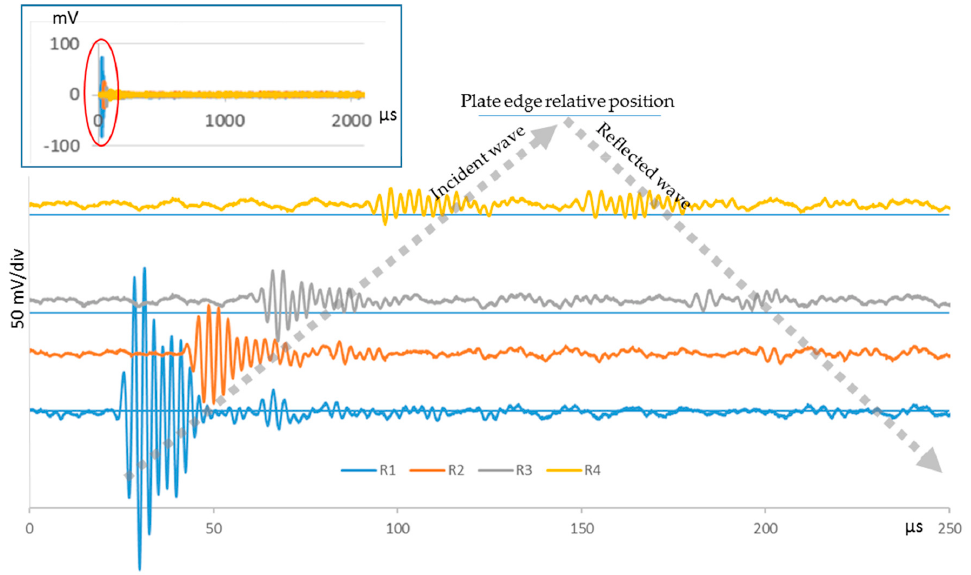
Figure 4. Signals acquired at R1–R4 during the basic UGWT. The upper part corresponds to the signal acquisition for 2 ms. The lower part corresponds to the significant part of the signals, when their amplitude is greatest. An offset proportional to the distance between adjacent PWAS is added to each signal to help understanding. Table 1. Magnitudes measured in the PWAS and calculated during the basic